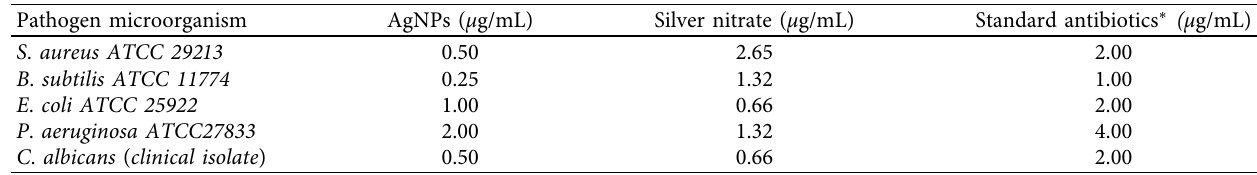
Figure 4: FESEM (a), TEM (b), and EDX (c) analysis data of silver nanoparticles. Table 1: MIC values of AgNPs, silver nitrate solution (5mM AgNO 3 ), and effect of standard antibiotics on the growth of pathogen bacterial and fungal